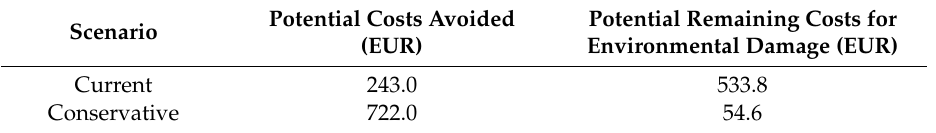
Table 5. Potential costs avoided based on nitrogen metabolic capacity of canals and ditches and potential damage costs for the remaining N output in current and conservative scenarios, calculated per kilometer of canals.